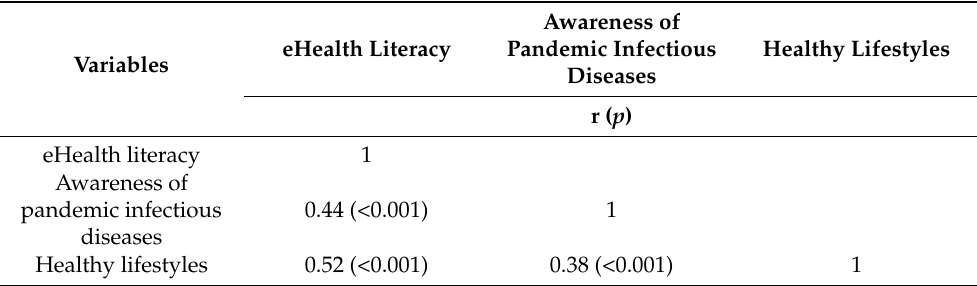
Table 3. Correlations among eHealth literacy, awareness of pandemic infectious diseases, and healthy lifestyles. ( n = 138). Awareness of eHealth Literacy Pandemic Infectious Variables